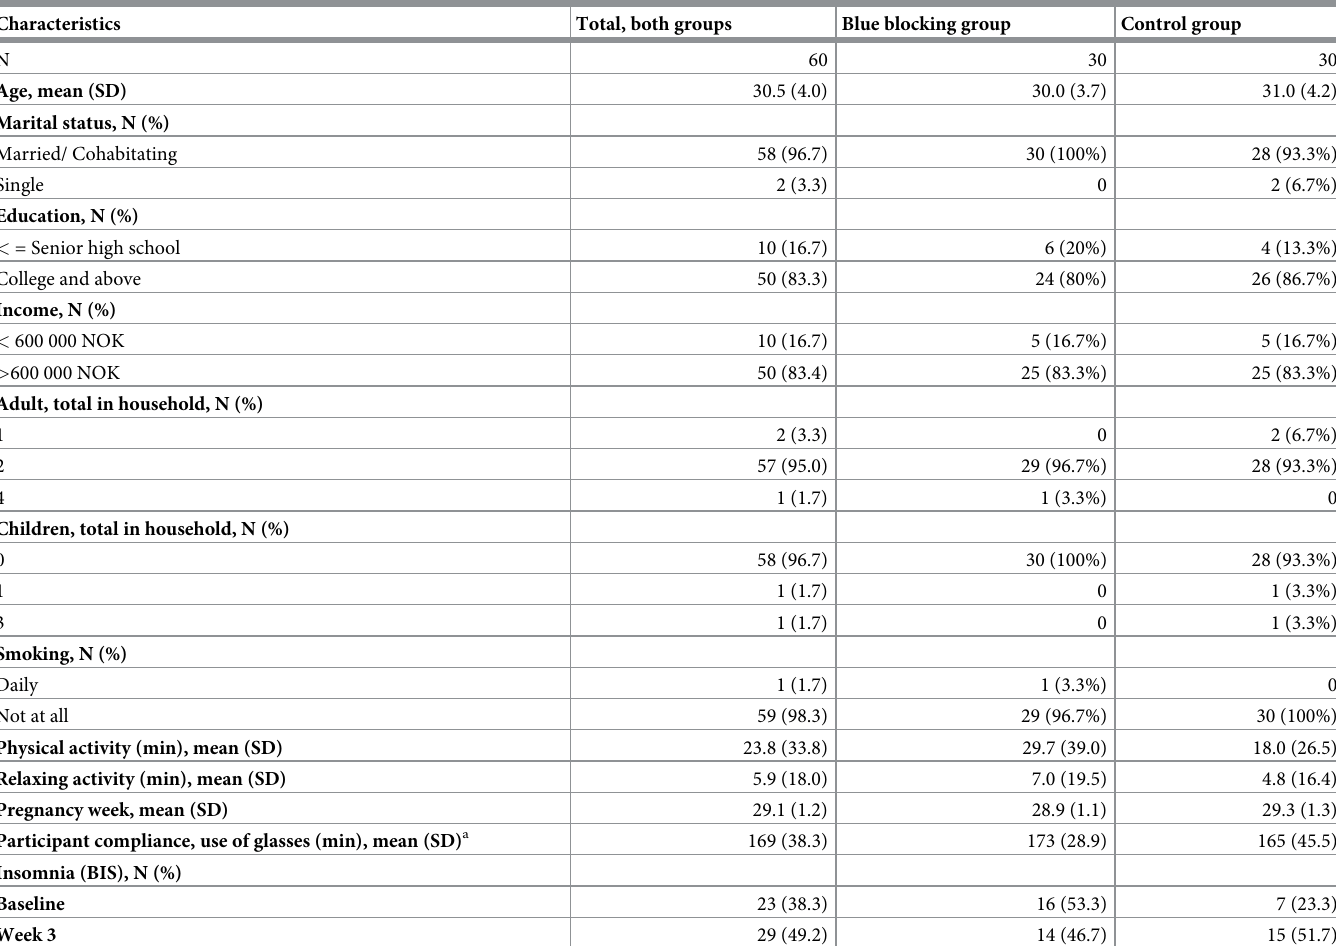
Table 1. Demographic factors for the blue-blocking- and control-group (self-reported